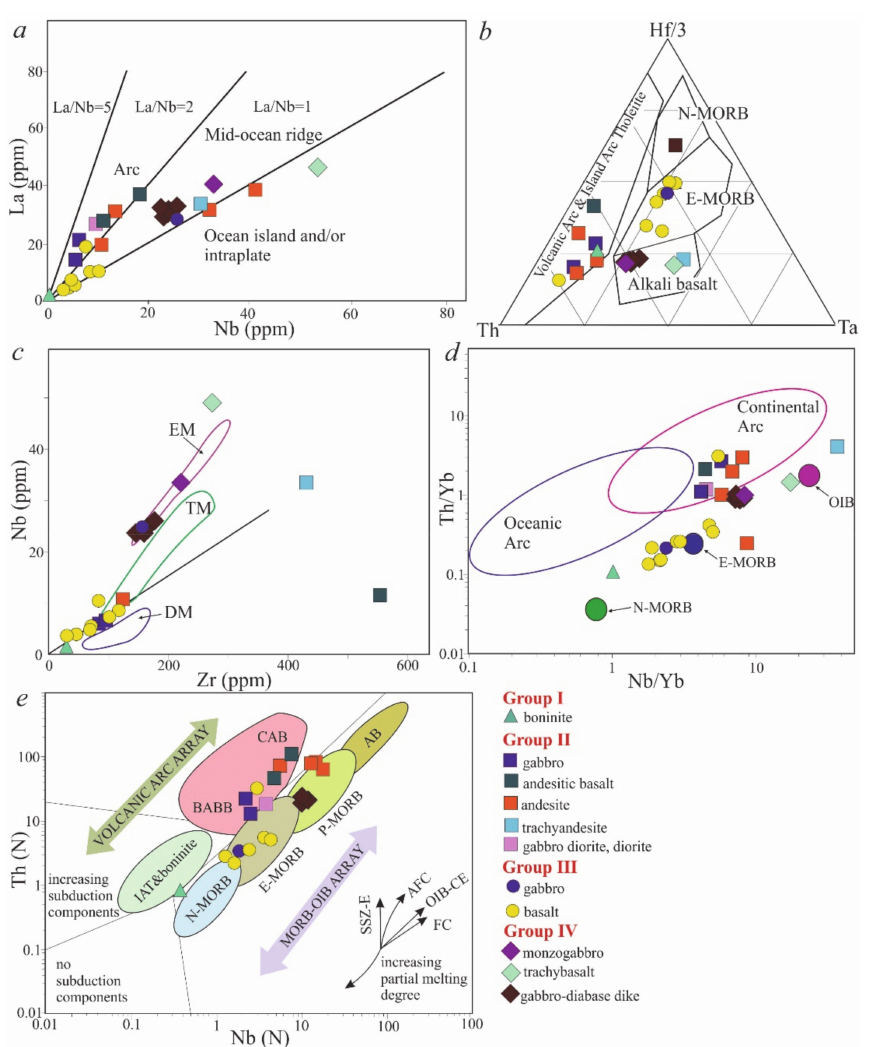
Figure 17. Tectonic discrimination diagrams for the Ulan-Sar’dag m é lange. ( a ) Nb vs. La